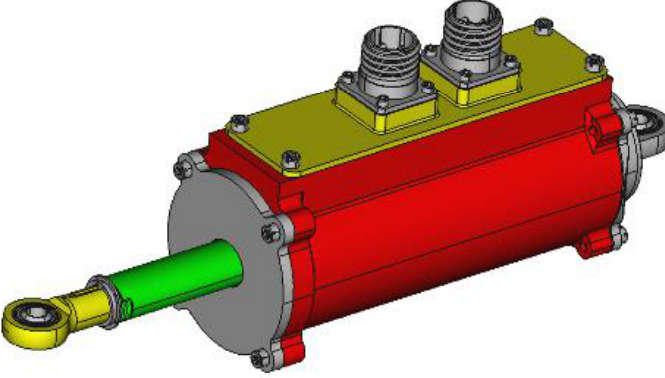
Figure 7. Electromechanical actuator for morphing winglet application.